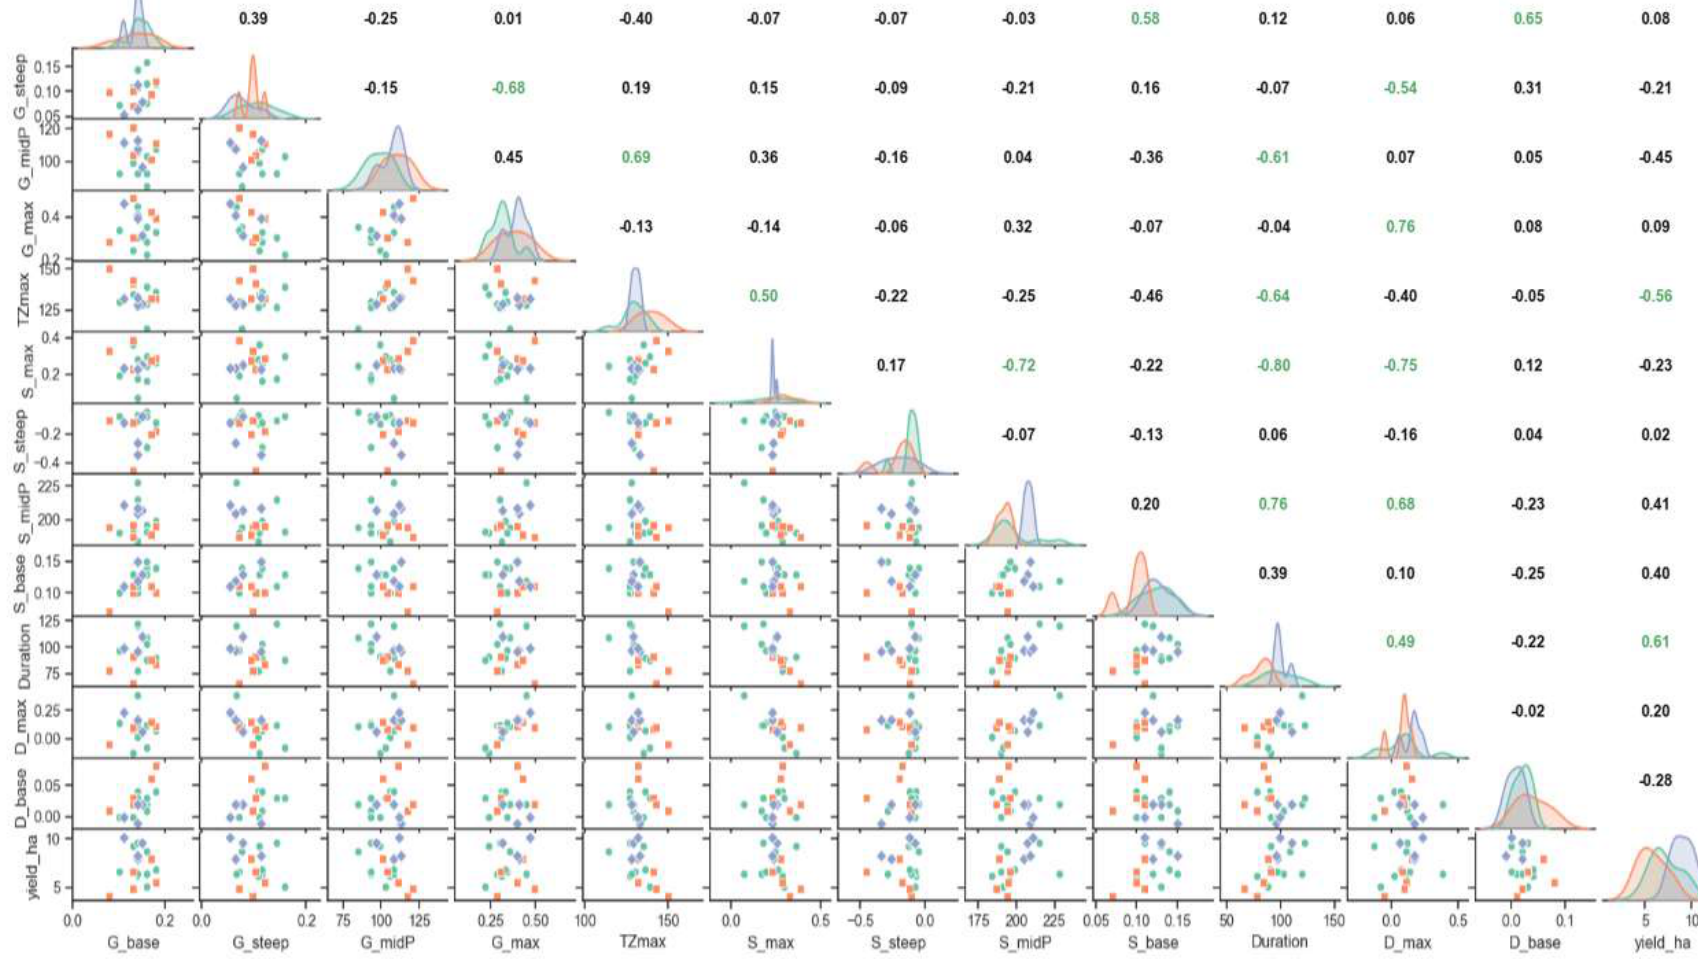
Figure 9. Correlation matrix with 2017 (green circles), 2018 (red squares), and 2019 (blue diamonds), using the 18 fields. R values are colour-coded green when there was a 95% level of significance for a two-tailed test.